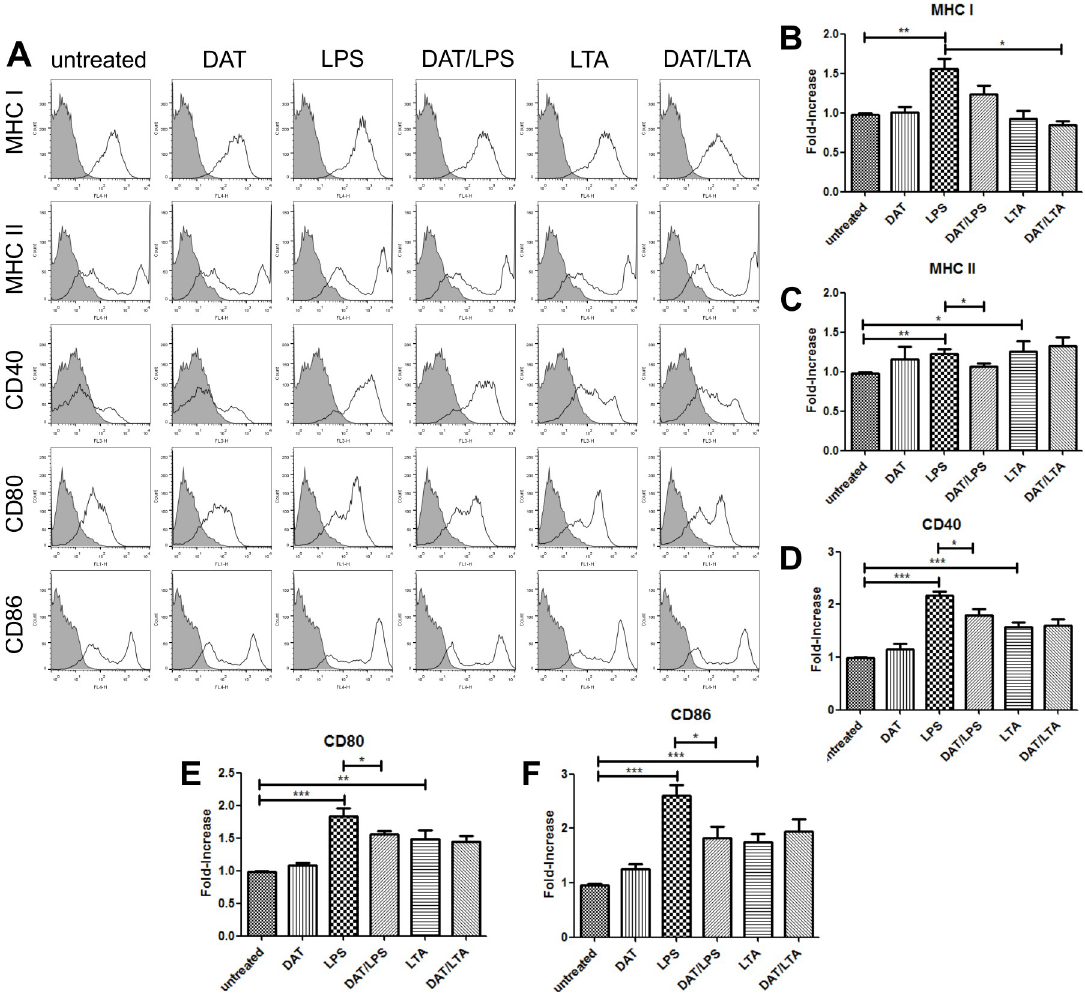
Fig 4. Di- O -acyl trehalose antagonizes the effects of LPS on DCs maturation. LPS, a TLR-4 agonist increase the levels of MHC-I, MHC-II, CD40, CD80 and CD86 (p < 0.005; unpaired t Student’s test) (B-F). Similar effects are obtained with LTA, a TLR-2 agonist. Pretreatment of with 10 μ g DAT for 1 h diminished the effects of LPS on DC maturation significantly (p < 0.05; unpaired t Student’s test) (B-F). DAT had no effects on LTA induced DC maturation.